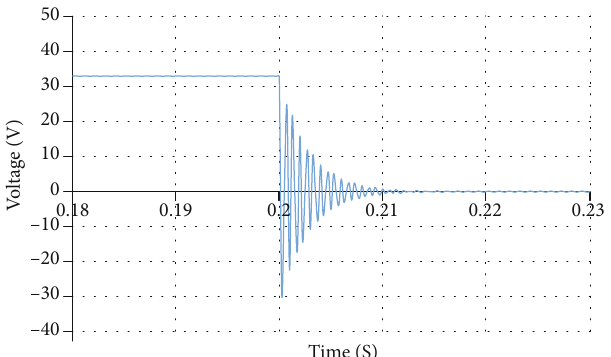
Figure 47: Detection of converter diode